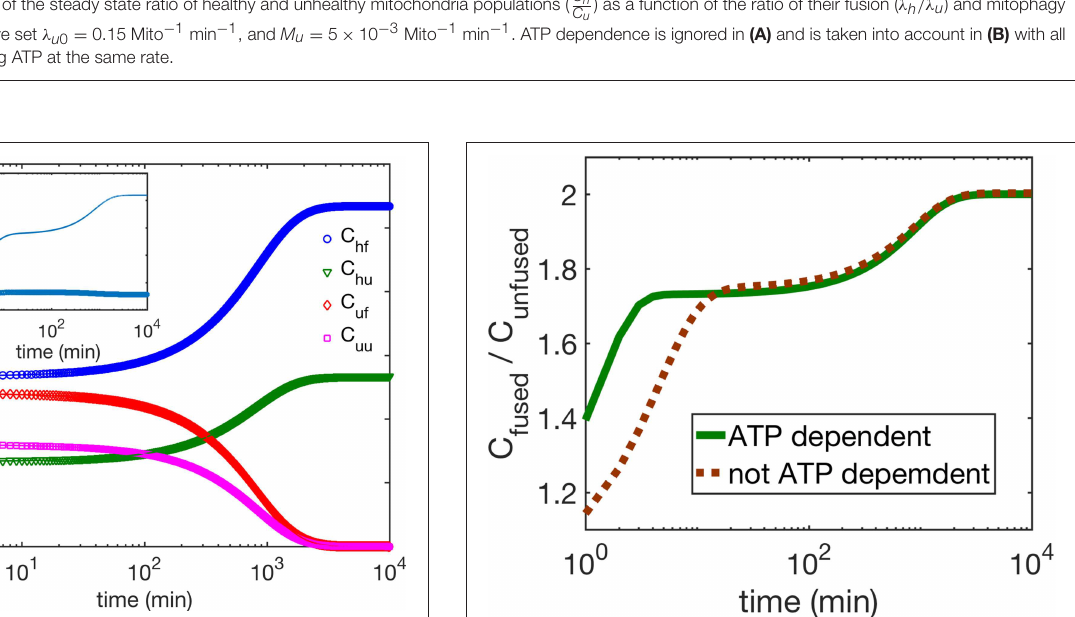
FIGURE 3 | Heat map of the steady state ratio of healthy and unhealthy mitochondria populations ( C h C